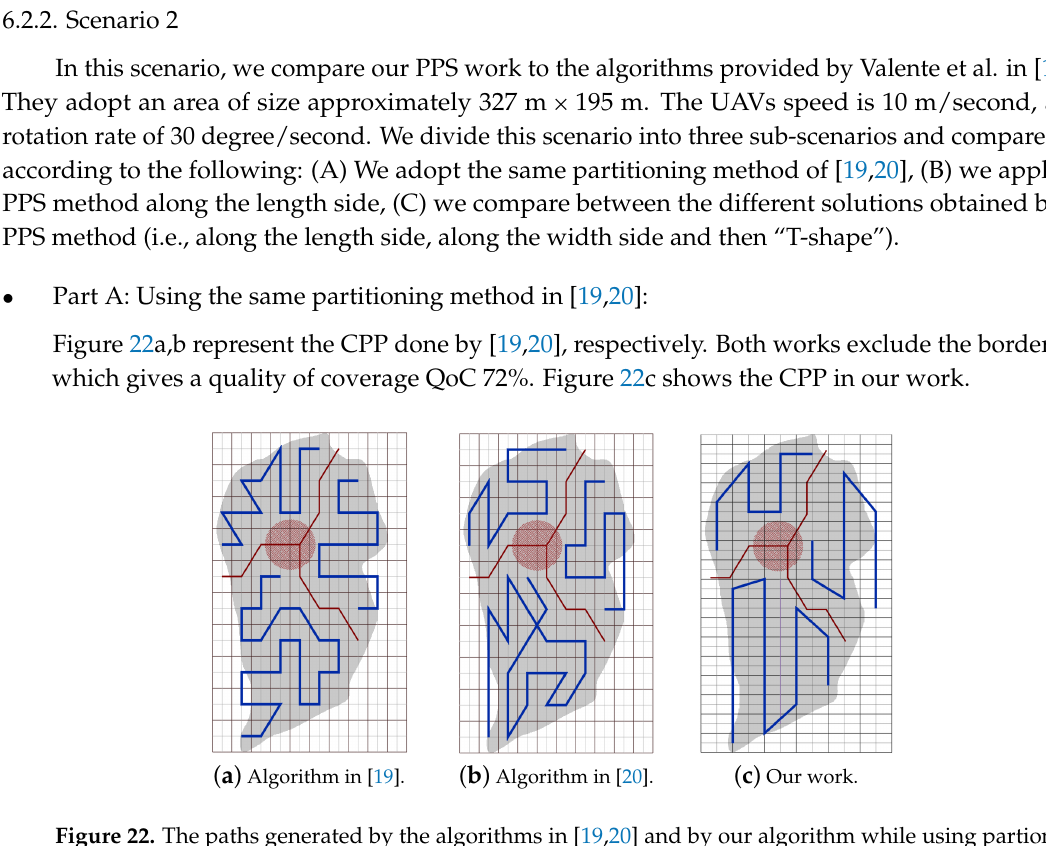
Figure 22. The paths generated by the algorithms in [19,20] and by our algorithm while using partion method in